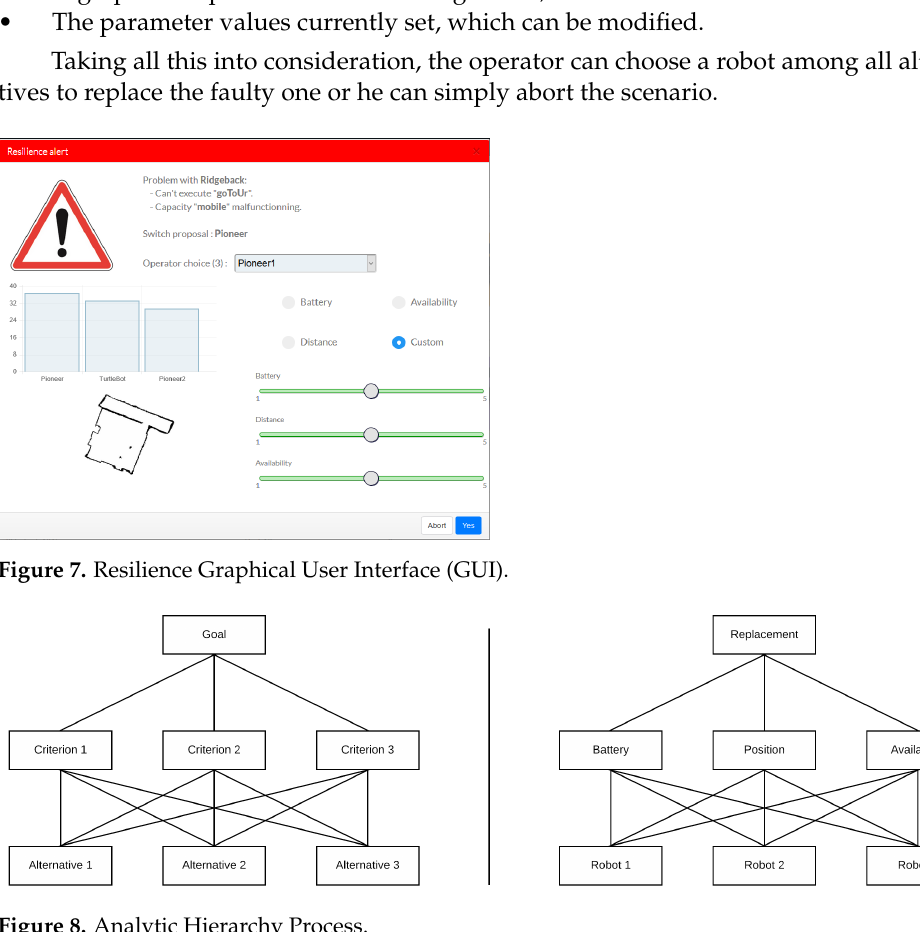
Figure 8. Analytic Hierarchy